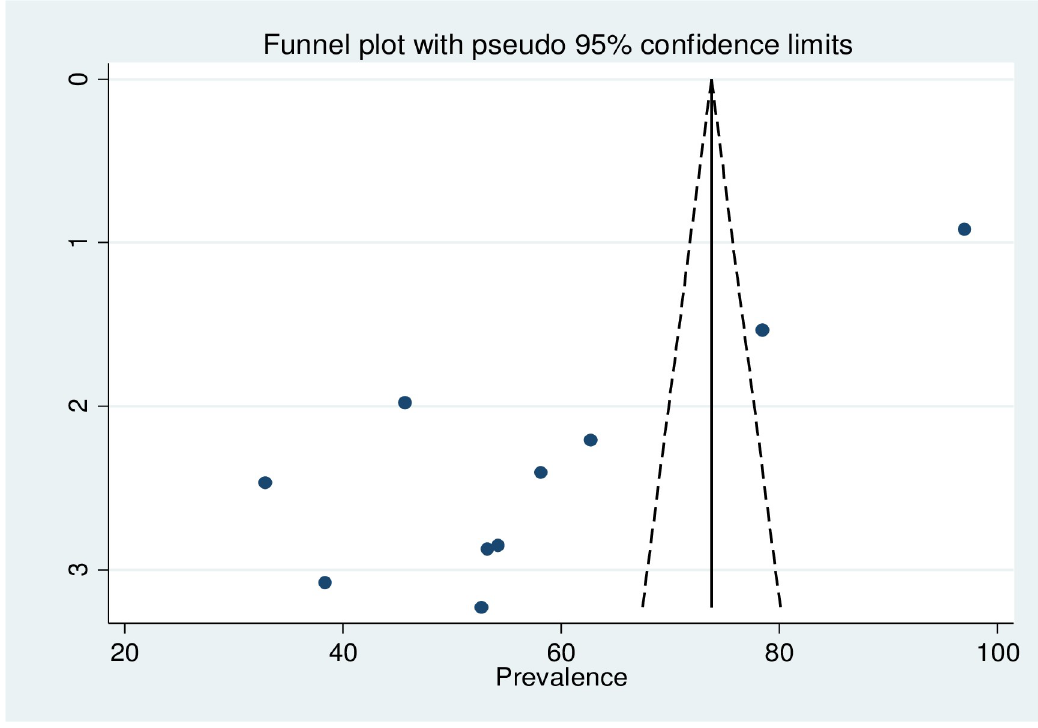
Fig 4. Graphic representation of publication bias using funnel plots of all included studies,